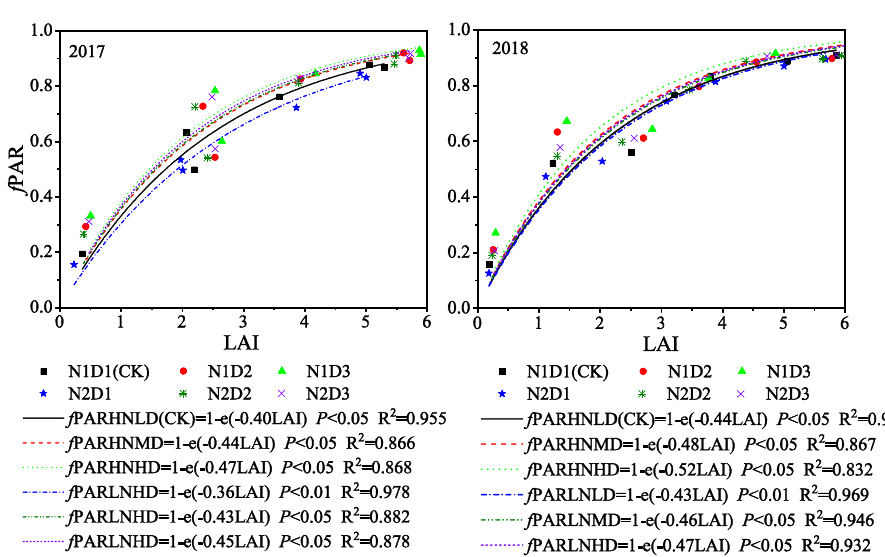
Figure 6. Relationship between the fractions of PAR intercepted ( f PAR) and the leaf area index (LAI) of maize in different planting